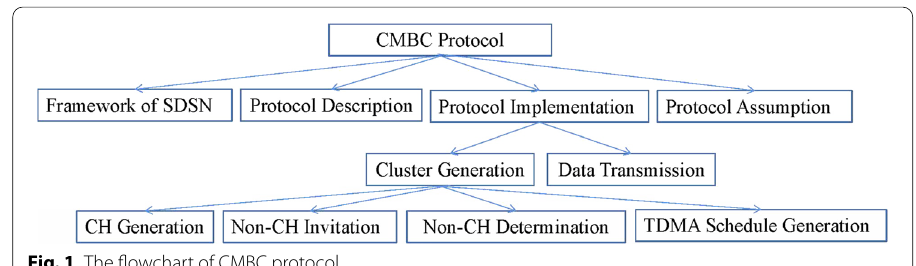
Fig. 1 The flowchart of CMBC